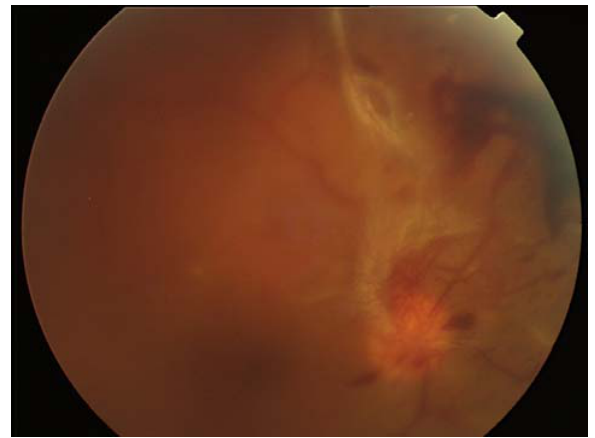
FIGURE 3. Case 2 RE. There is a moderate amount of blood inside the vitreous cavity. A new-vessel bunch emerges from the superior half of the optic disk accompanied by fibrous tissue at 12 o’clock. A big dark preretinal hemorrhage is seen in the superior retinal